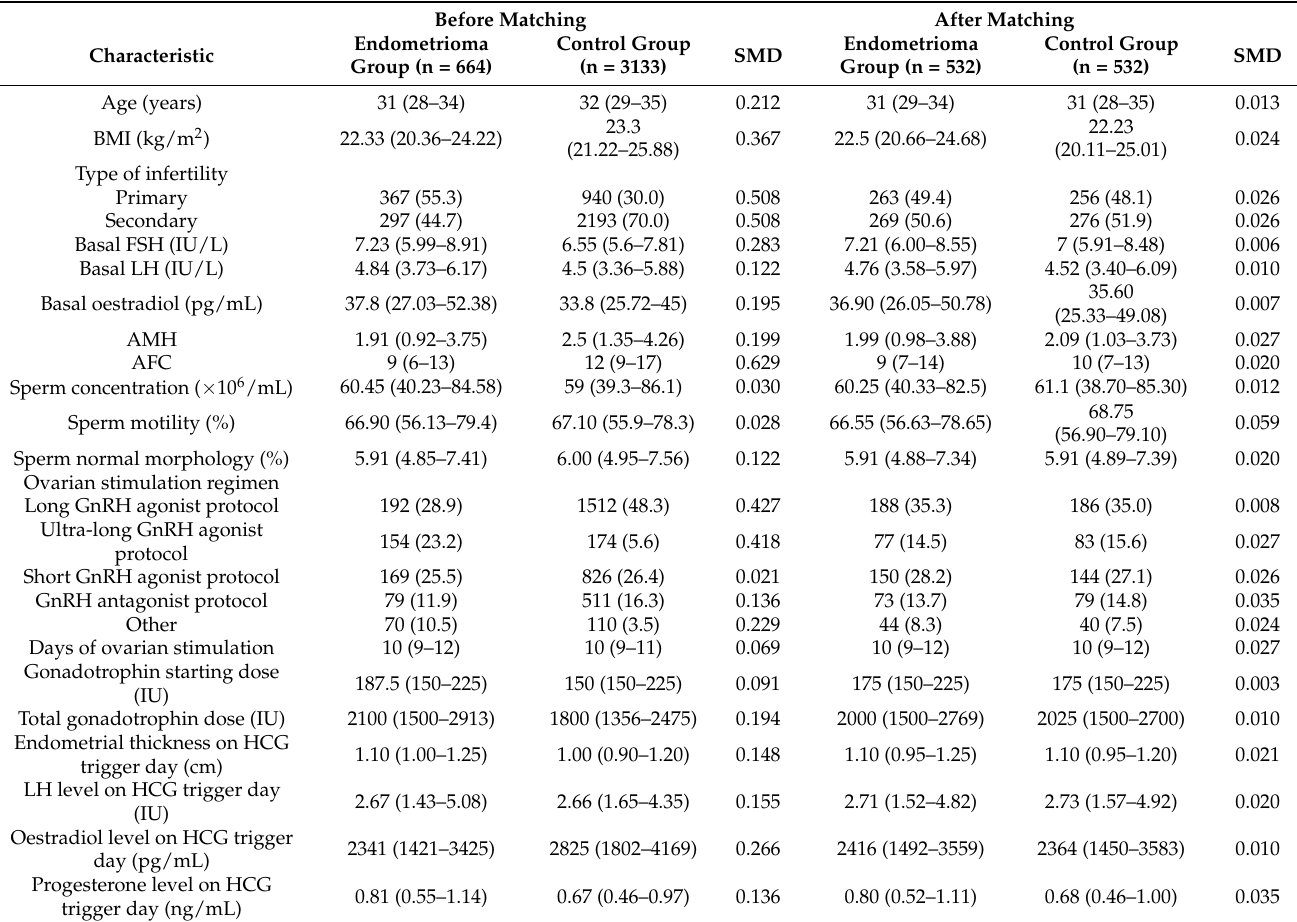
Table 1. Baseline characteristics of the women with endometrioma and control group before and after